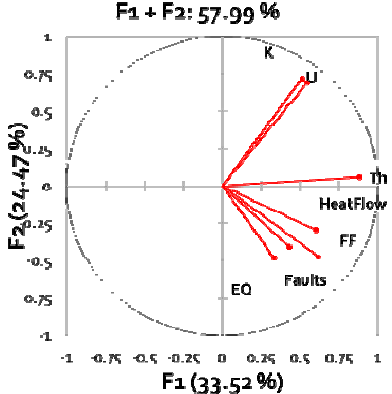
Figure 9. Raw PCA result. Loading plot, showing the coe ffi cients of each variable for the first component versus the coe ffi cients for the second component. This graph shows which variables have the largest e ff ect on each component. Percentages: Explained variance (in percentages) of first principal principal components F1 and F2 (From [30]). components F1 and F2 (From